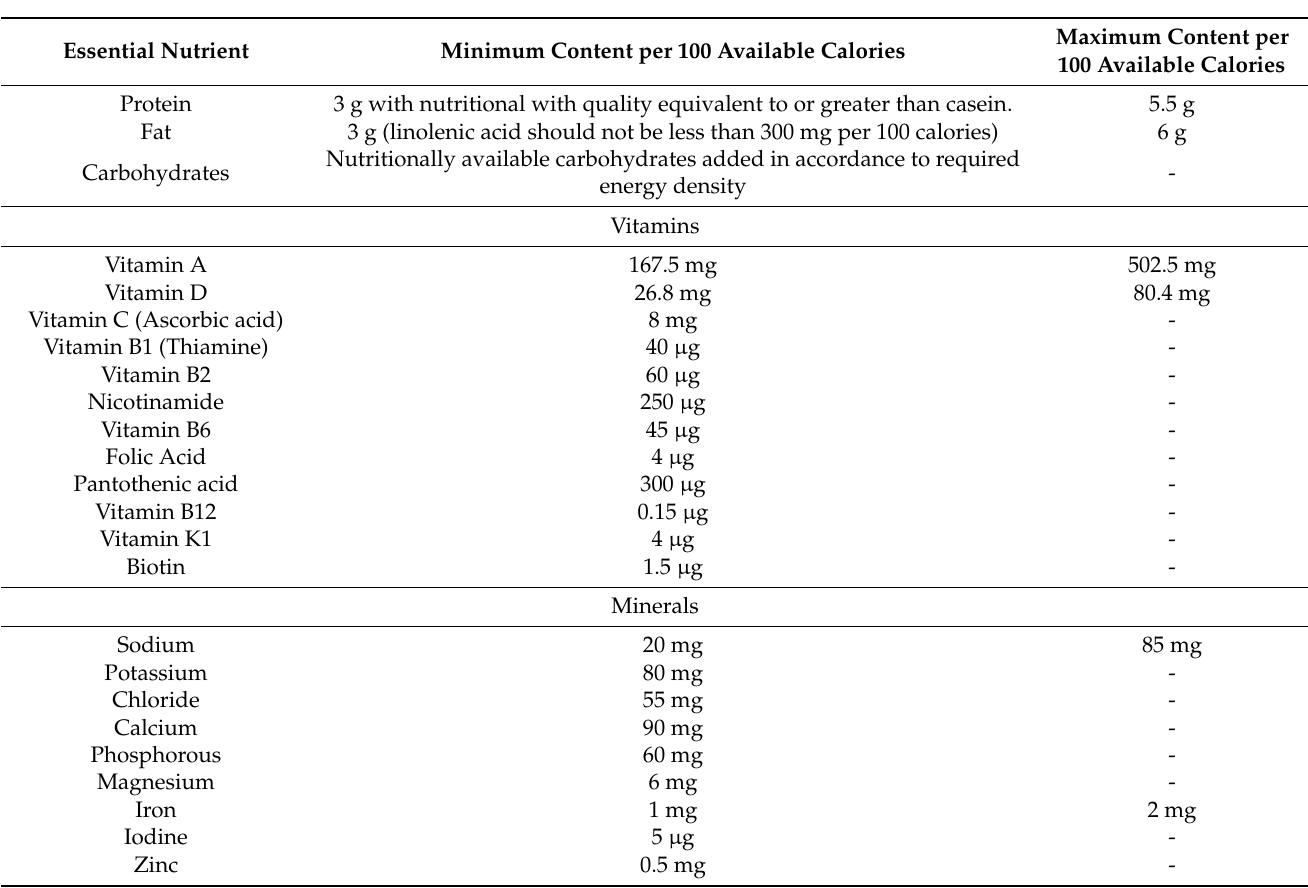
Table 3. Essential nutrients listed in Codex standards for follow up formula (complementary food) with minimum and maximum contents. Obtained from Codex Alimentarius Standard for Follow Up Formula [11].